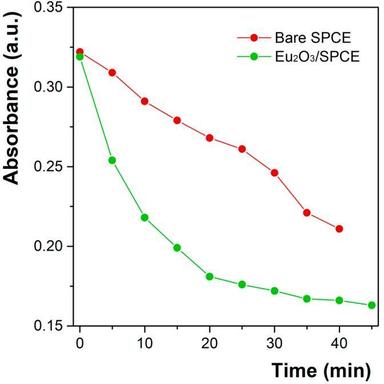
Comparison between bare and modified SPCE toward removal of RB52. Applied voltage 3 V, supporting electrolyte KCl at native pH (5.6) of the solution of the dye.